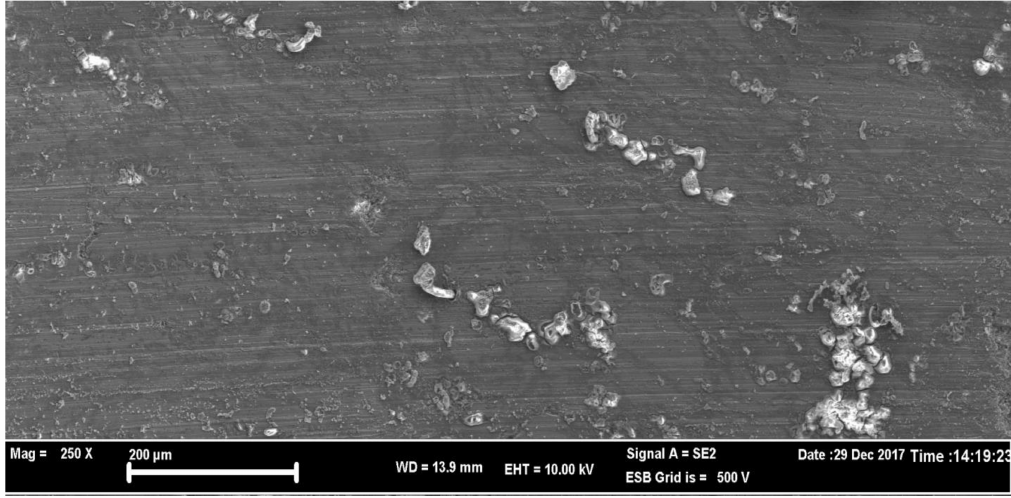
Figure 15. SEM image of the drilled surface at Vc = 50 m/min and f = 0.10 mm/rev when using the CVD-coated drill